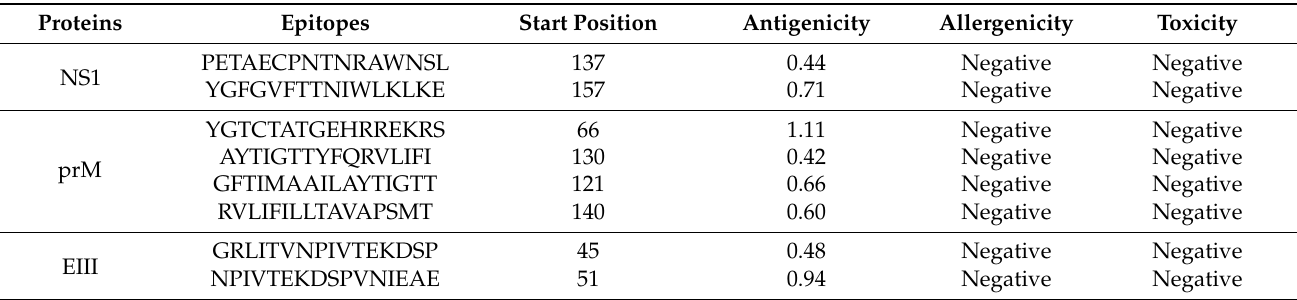
Table 2. Physicochemical Profiling of Linear B-Cell Epitopes.